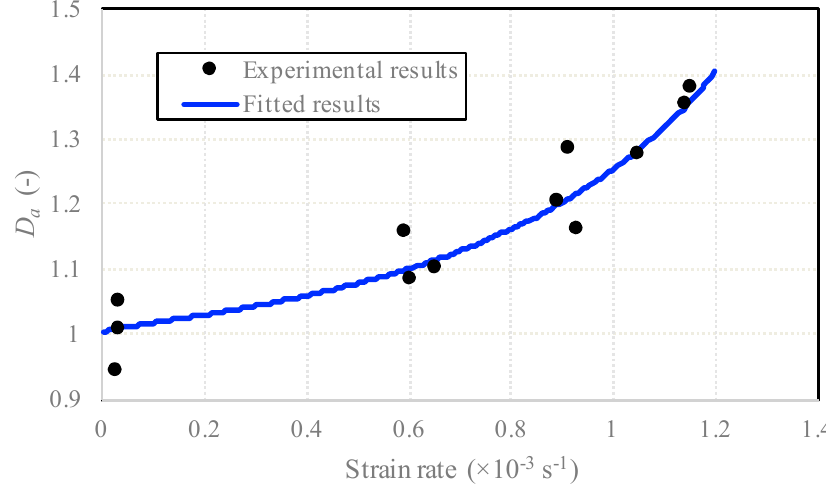
Figure 13. The strengthen coefficient-strain rate with respect to the strain rate.